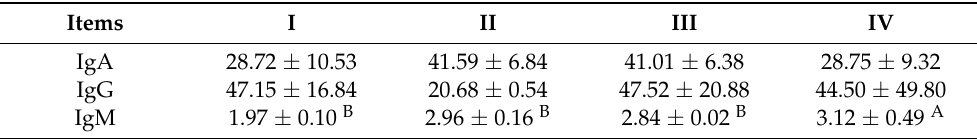
Table 8. Effects of dietary supplementation with different inclusion of SMS-MP on serum immune globulin of growing sika deer (mg/mL).